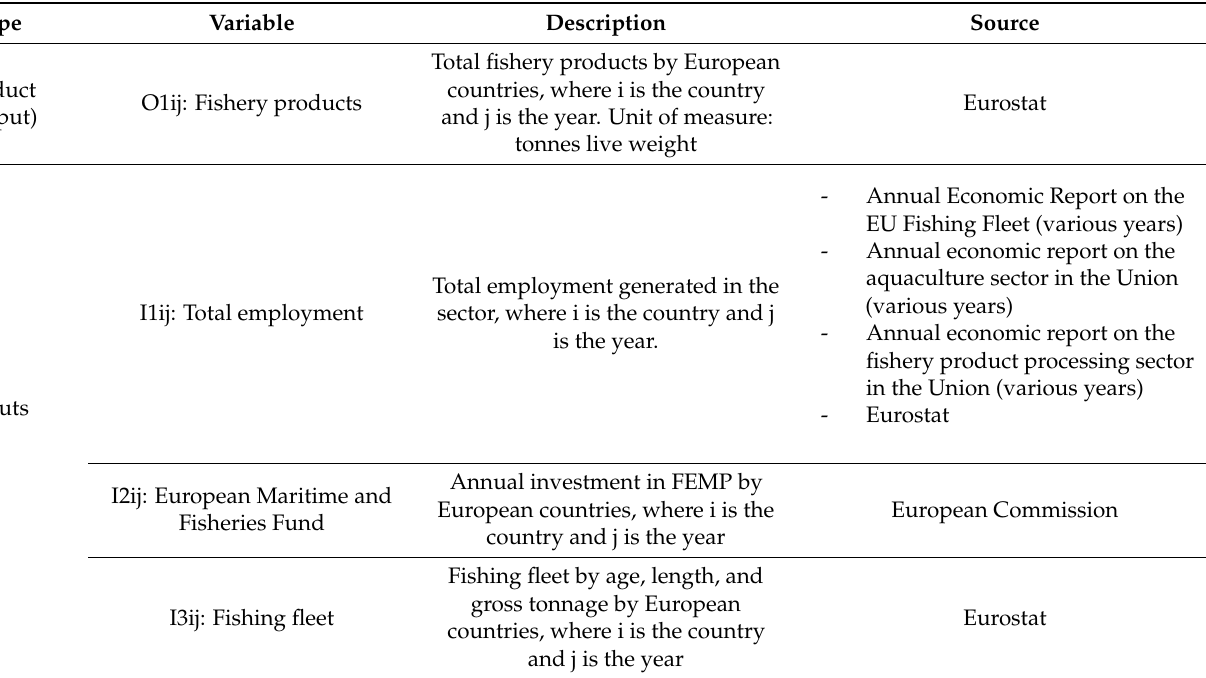
Table 1. Production function of the degree of efficiency in the use of Sea and Fishing